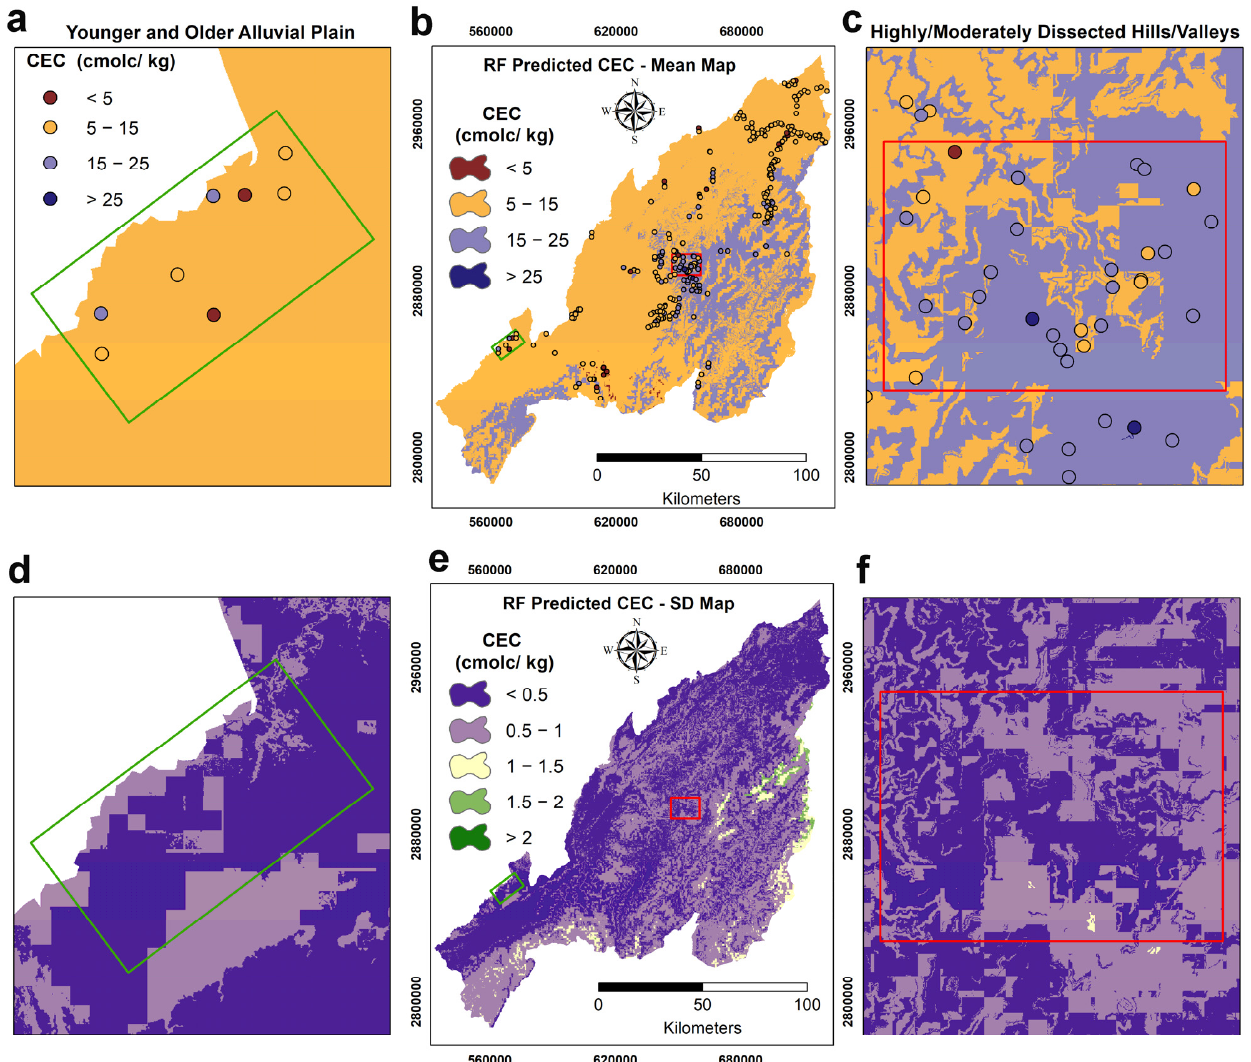
Figure 5. Digital maps of CEC (0–30 cm) were generated by applying a random forest (RF) model: Zoomed to a young and older alluvial plain area as mean CEC map ( a ) and as uncertainty CEC map ( d ); mean CEC map over Nagaland ( b ) resulting from the prediction among 10 iterations; zoomed to a highly/moderately dissected hills and valleys as mean CEC map ( c ) and as uncertainty CEC map ( f ); uncertainty CEC map over Nagaland ( e ) resulting from the standard deviation of 10 iterations.